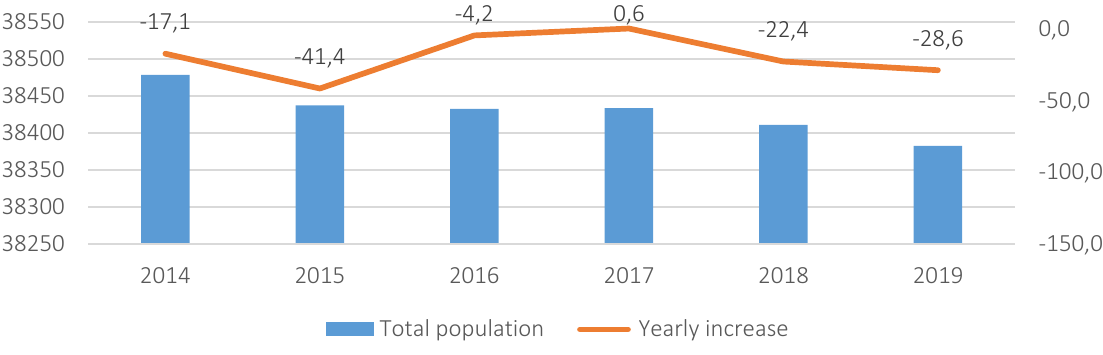
Figure 1. Population in 2014–2019